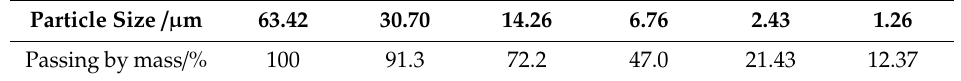
Table 3. Particle size distribution of mineral